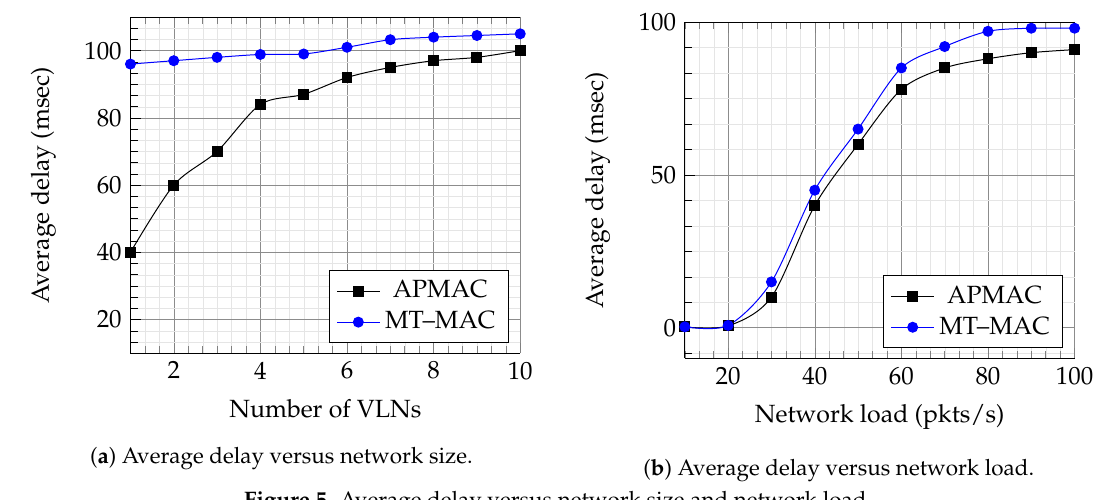
Figure 5. Average delay versus network size and network